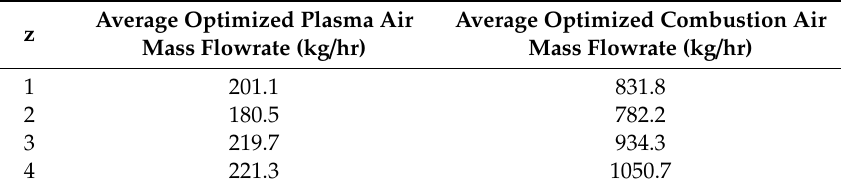
Table 6. Plasma air mass flow rate and operational